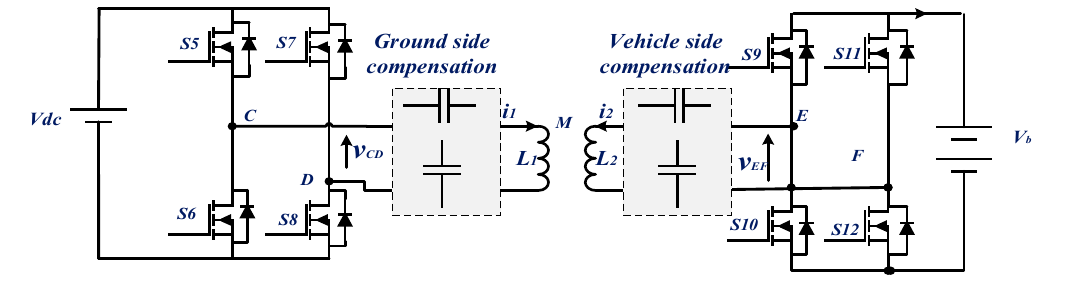
Figure 2. Circuit topology of a WPT charger.